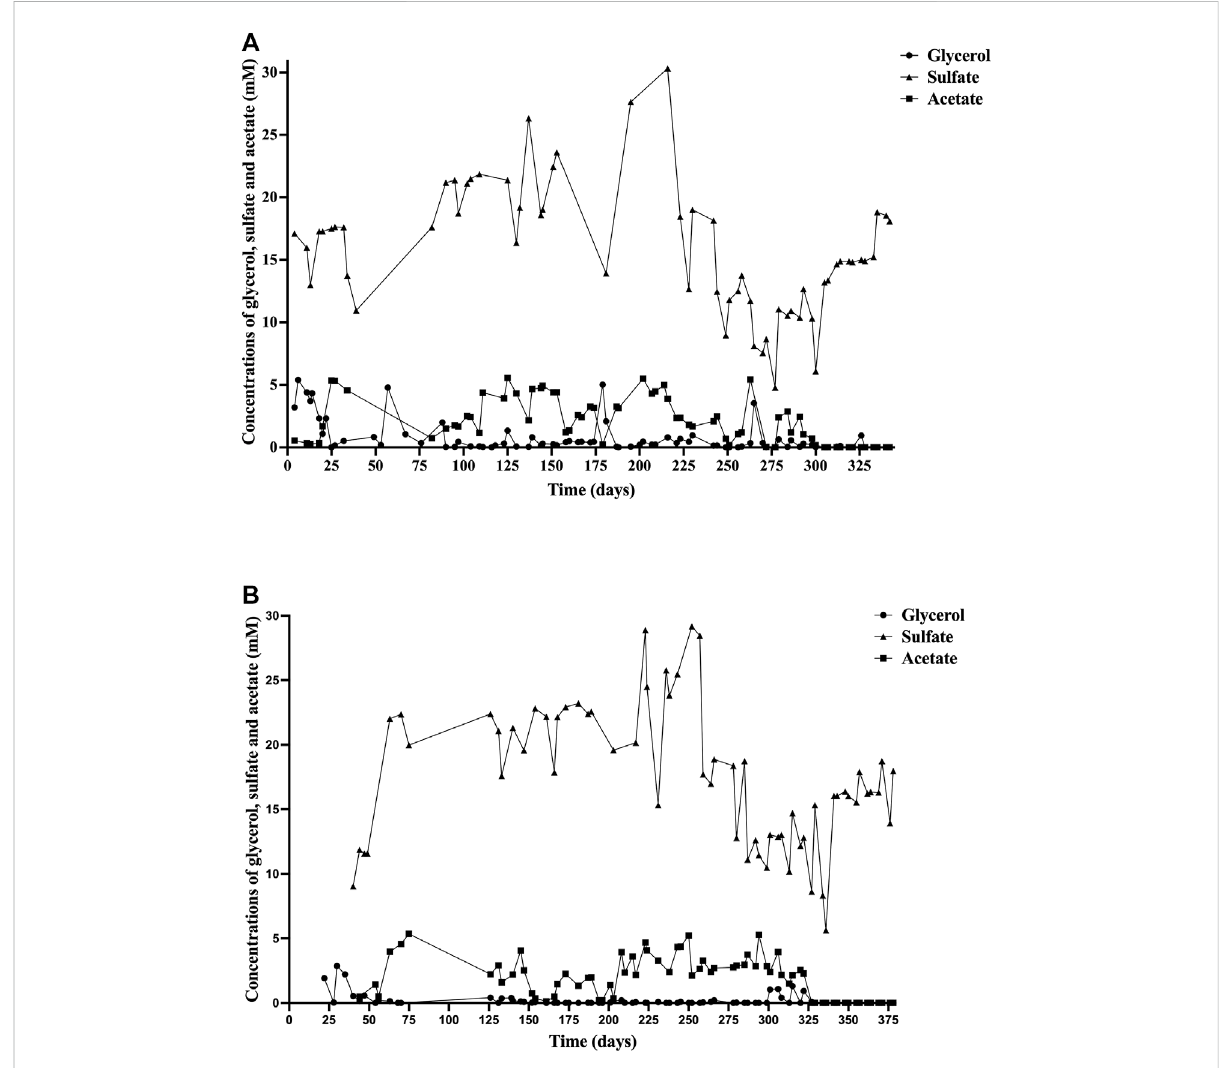
FIGURE 1 Concentrations of glycerol ( ○ ), sulfate ( ▲ ), and acetate ( ■ ) during the experiment in: (A) Bioreactor I (Bio I); (B) Bioreactor II (Bio